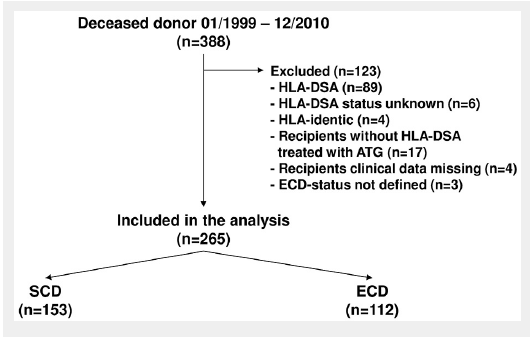
Study flow. ATG = anti-T-lymphocyte globulin; ECD = expanded-criteria donor; HLA-DSA = donor-specific HLA-antibodies; SCD = standard-criteria